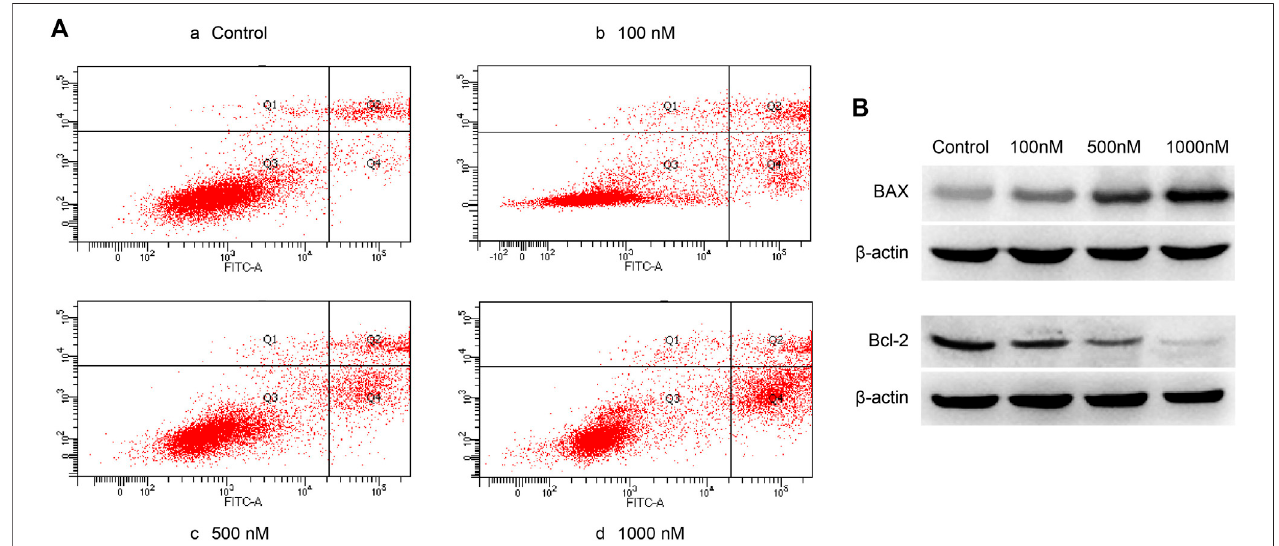
FIGURE 8 | Celastrol promoted ovarian cancer cell apoptosis. (A) The Q4 quadrant showed that celastrol promoted ovarian cancer cell apoptosis after the administration of concentrations ranging from 100 nM to 1 µM (100, 500, and 1,000 nM). (B) WB analysis showed that celastrol increased BAX and decreased Bcl-2 ranging from 100 nM to 1